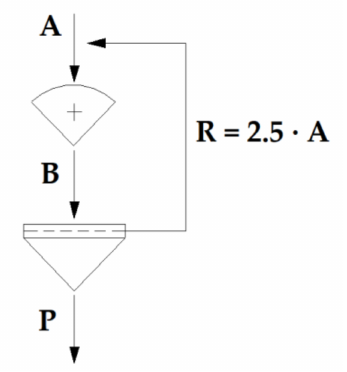
Figure 1. Closed-circuit BBM test objective